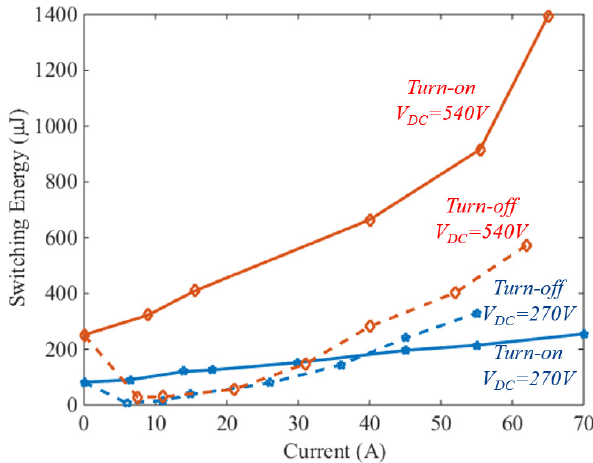
Figure 6. Experimental switching energy of the CCS050M12CM2 SiC module from Wolfspeed, as a function of switching current and voltage.